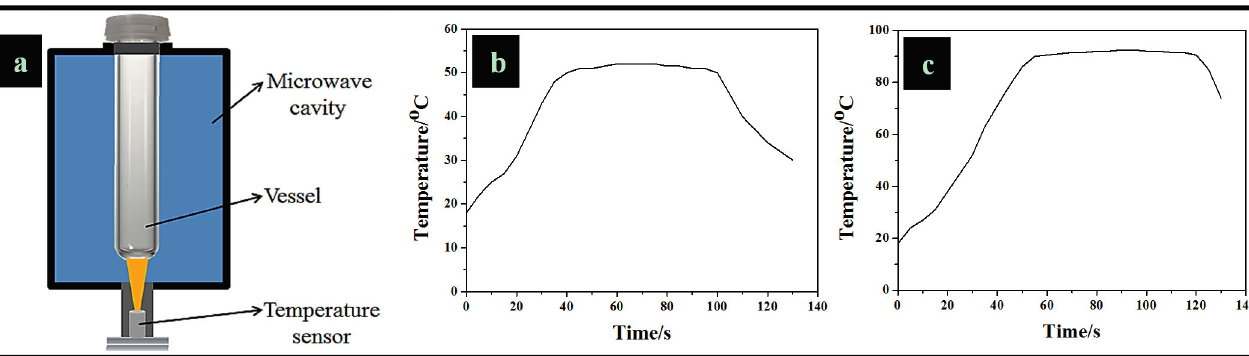
Figure 4. ( a ) Schematic showing the microwave chamber with temperature sensor for recording the temperature profiles during microwave anneal. Representative temperature profiles of the (BCP + substrate) system at ( b ) 50 °C and ( c ) 90 °C for 60